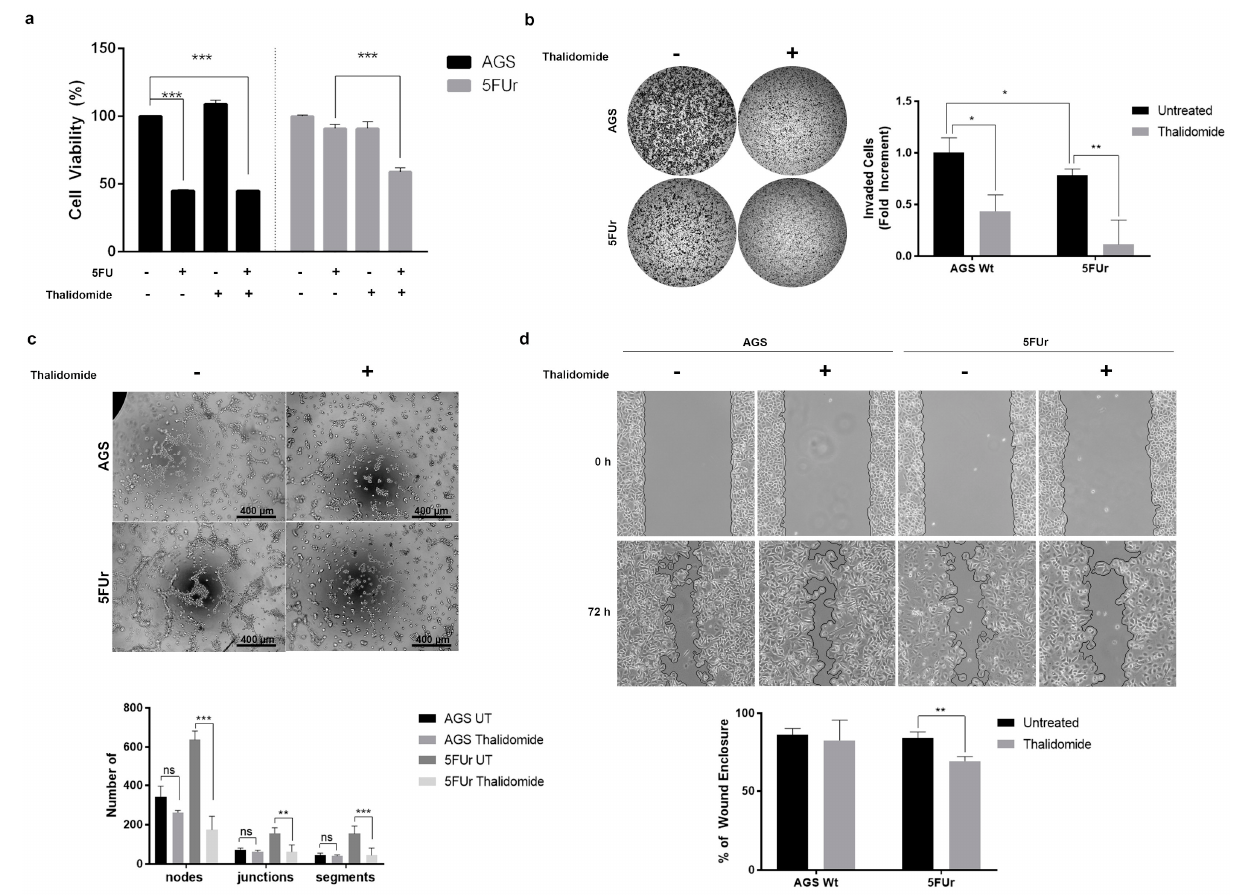
Figure 6. Thalidomide reverts 5-FU resistance. ( a ) Cells were exposed to Thalidomide 200 μ M for 72 h and cell viability was assessed by MTT assay. ( n = 5). ( b ) Cells were harvested and plated on Thalidomide 200 μ M for 6 h ( n = 3). ( c ) AGS WT and 5FUr were plated on Matrigel and after 3 h Thalidomide 200 μ M was added. Pictures were taken at 3 h after the treatment. The representative images and the number of Nodes, Junctions and Segments are presented ( n = 3). Images were captured at 10X magnification—scale bar 400 μ m. ( d ) Representative images of wound healing after scratching (T0) and 72 h later. Quantification (below) of the wound enclosed area ( n = 4). Results of representative experiments are shown. Data are presented as mean ± SD. ns means not statistically significant; * p < 0.01; ** p < 0.001; *** p < 0.0001 (Two-way ANOVA test).